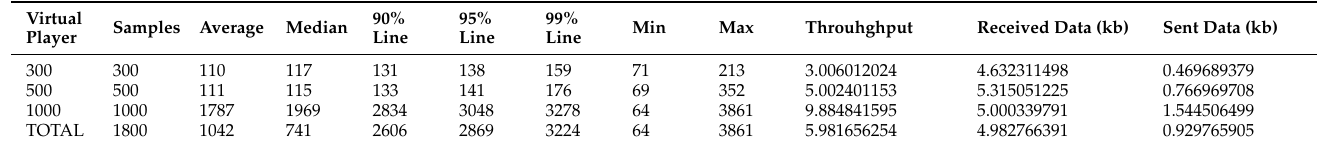
Table 6. Overview of Data access points from different devices connected to IoT gateways.